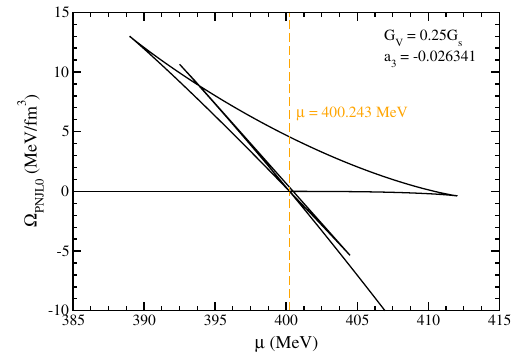
Fig. 9 Ω PNJL0 as a function of the quark chemical potential ( μ ) for G V = 0 . 25 G s and a 3 = − 0 .